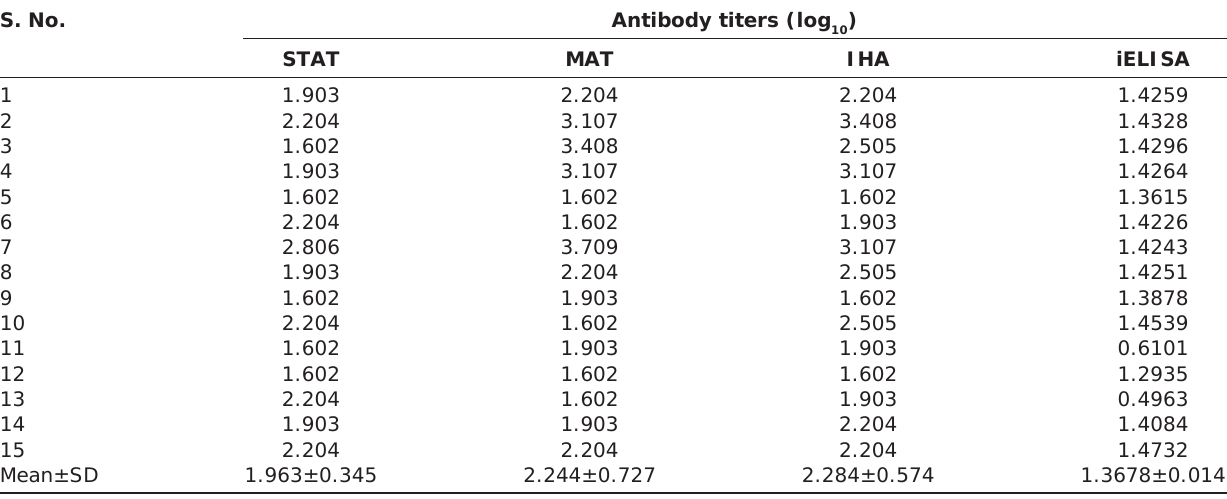
Table-2: Antibody titers of cattle naturally infected with brucellosis. S. No.